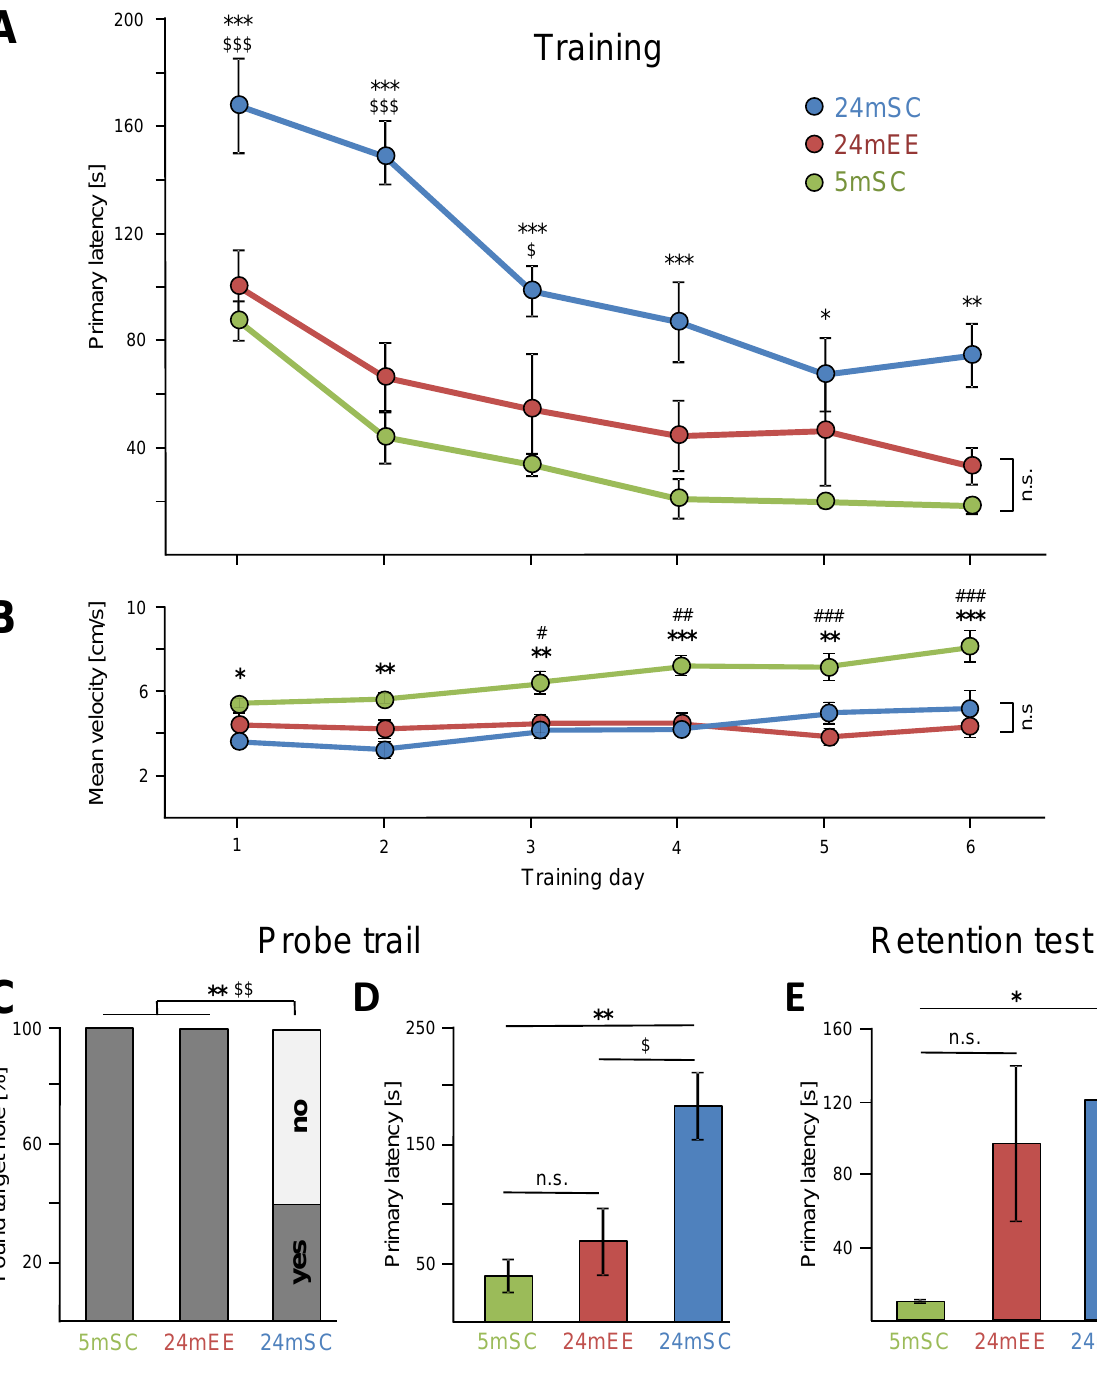
Figure 1. Late-onset EE restores deficits in spatial learning and short-term memory in 24-month-old mice in the Barnes maze test. ( A ) Improvement over the training period was observed for all groups (F 5,110 = 26.44, p < 0.001). Under standard housing conditions, 24-month-old mice (24mSC, n = 10)